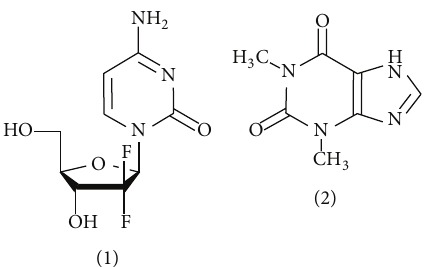
Figure 1: Chemical structures of gemcitabine (1) and theophylline